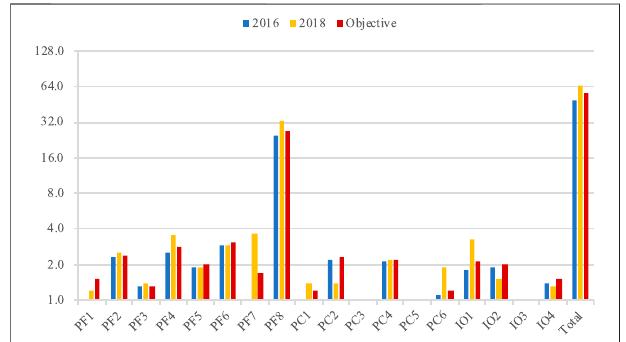
FIGURE4| Comparison ofevaluationresultsin2016and 2018.Thered bar is the development objective of C 10 in